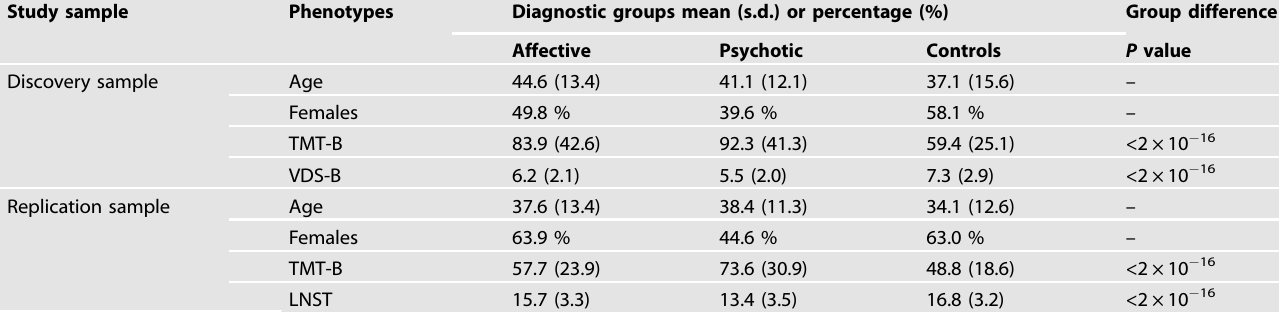
Table 1. Characteristics at visit 1 in discovery sample and replication sample by diagnostic